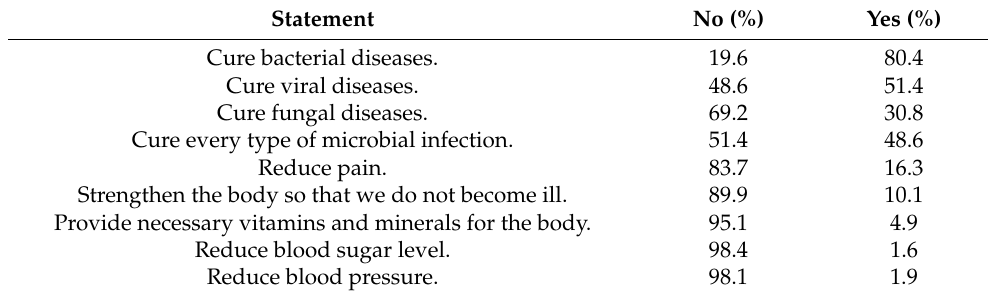
Table 1. Answers to the question “Which of the following are the purposes/uses of antibiotics?”.